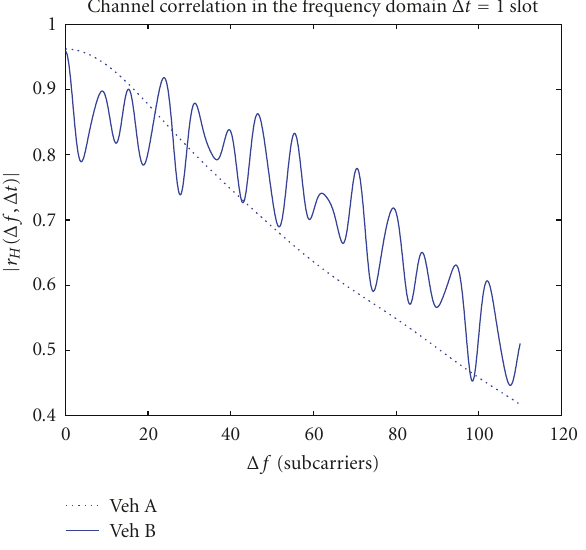
Figure 6: Expected number of collisions per symbol versus the number of users.